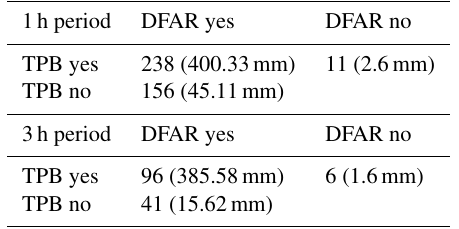
Table 2. Contingency tables of cases detected by each instrument over 1 (top table) and 3h (bottom table) accumulation periods. The sum of total accumulation measured by each instrument is provided in parentheses. Note that the amount provided for the yes/yes case represents the precipitation amount measured by the